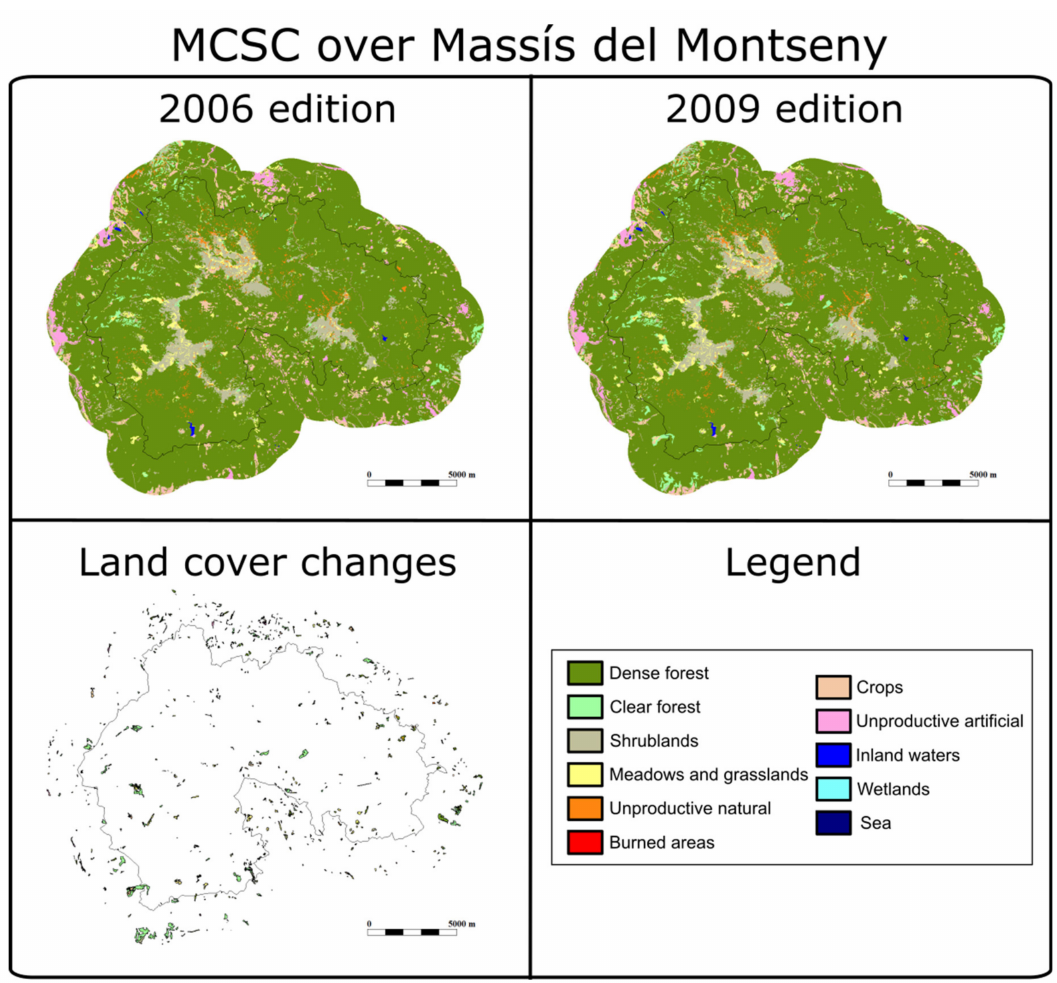
Figure 5. Land cover map for 2006 and 2009 and changes in the Mass í s del Montseny protected